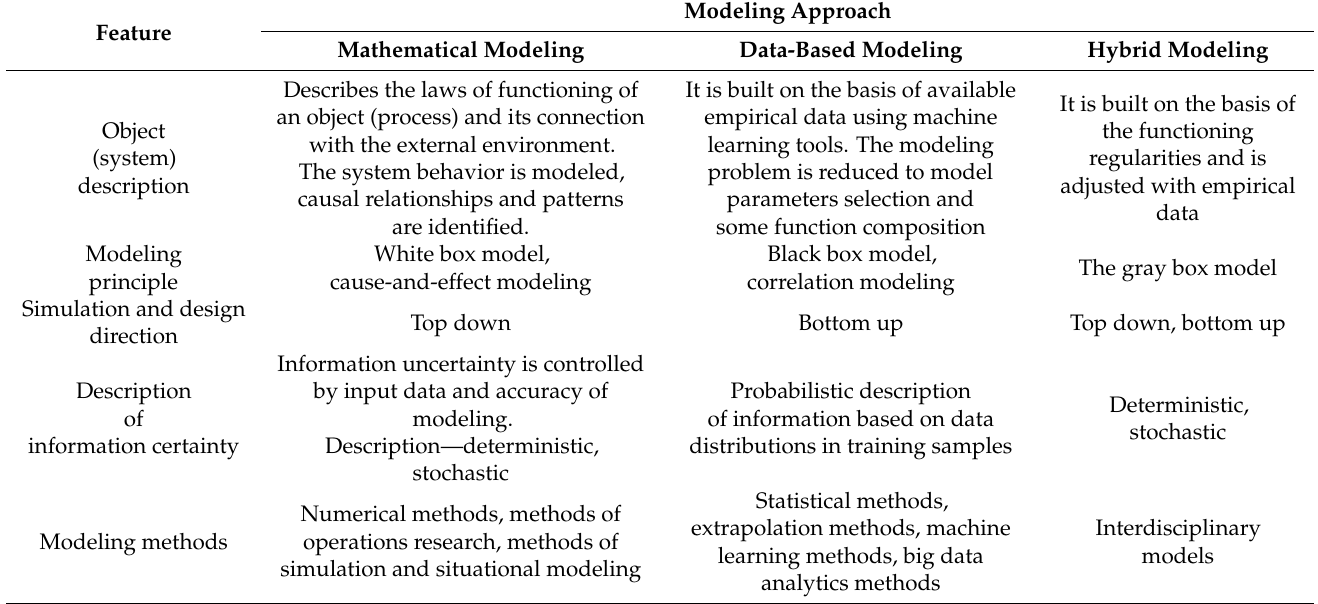
Table 1. Comparative analysis of the models for DTs of organizational and technical system